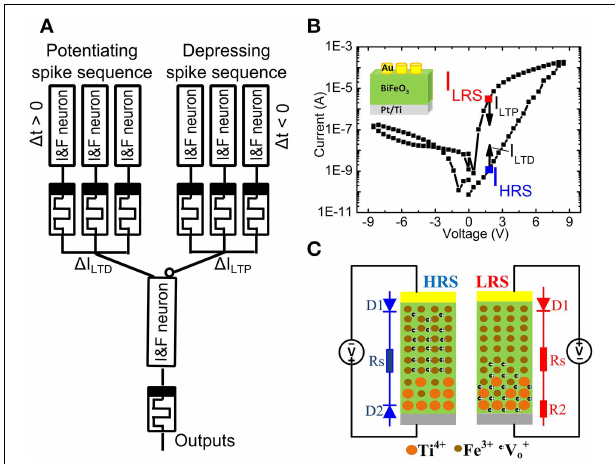
FIGURE 1 | (A) Schematic illustration of the memristor-based synaptic electronics. The artificial synapses are placed between Integrate & Fire neurons (I&F neuron). With a well-defined time delay 1 t between the pre- and post-spikes the internal state (“weight”) of the memristor is suitably changed. (B) Hysteretic current-voltage (IV) characteristics of a Au/BiFeO 3 /Pt memristor in LRS and HRS with a top electrode area of 4.5E4 µ m 2 under source voltages with maximum sweeping pulse amplitude of 8.5V and a pulse width of 100ms. The current in high resistance state I HRS and in low resistance state I LRS is read out at + 2.0V, after having switched the memristor into HRS and LRS, respectively. The long term potentiation current I LTP and the long term depression current I LTD lie below the reading current in LRS (I LRS ) and HRS (I HRS ). Inset shows the structure of a BFO memristor. (C) Schematic demonstration of the distribution of fixed Ti 4 + , fixed Fe 3 + and mobile V + o